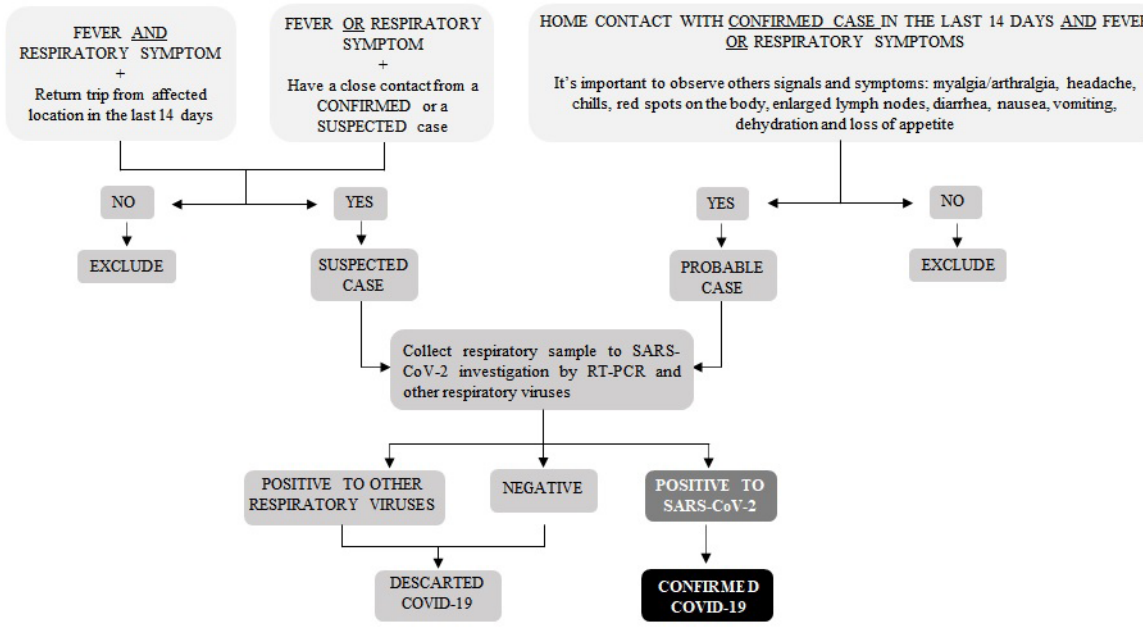
Figure 3. Flowchart with initial recommendations of the Brazilian Ministry of Health to the investigation of new cases by health professionals and sanitary vigilance (Brazilian Ministry of Health site, March 18 th ).